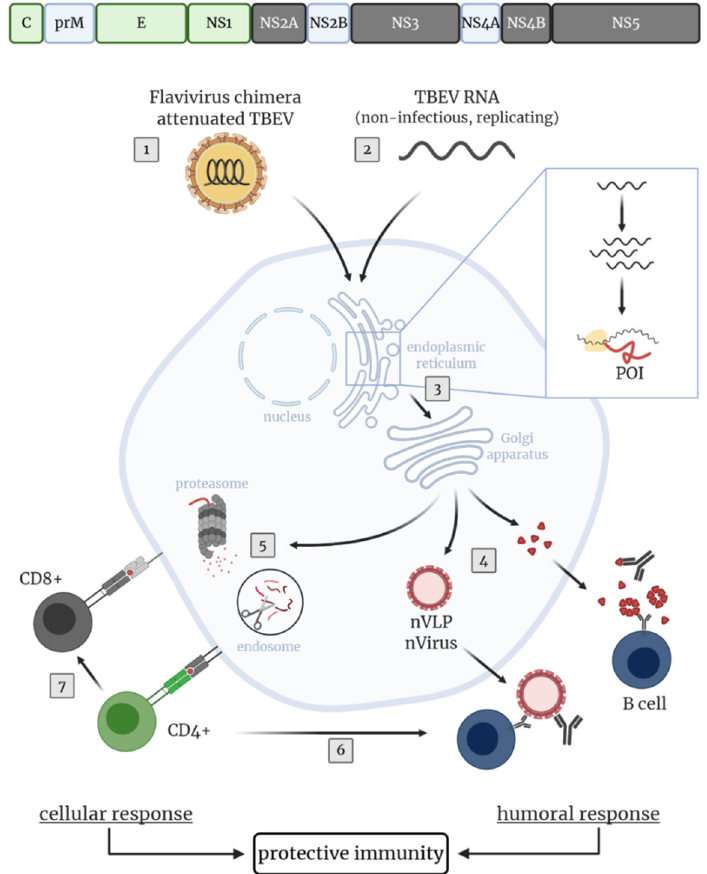
Figure 3. Inclusion of flavivirus non-structural proteins to enhance vaccine-induced immunity. The TBEV polyprotein with proteins inducing CD4 + (C, E, NS1) and CD8 + (NS2A, NS3, NS4B, NS5) T cell responses is shown. Upon immunization with live attenuated flaviviruses (1) or non-infectious, replicating TBEV RNA (2), structural as well as non-structural proteins are included, promoting a humoral but also an e ffi cient cellular immunity. (3) Immunization leads to the synthesis of proteins of interest (POIs), which are processed on di ff erent pathways leading to humoral and / or cellular immune responses. (4) Humoral immune response: POIs are either secreted into the extracellular space (NS1) or assemble into novel VLPs (nVLPs) or virions (nVirus) which are subsequently released from the cell. Thus, TBEV-specific B cells and antibodies are induced. (5) Cellular immune response: The POIs are degraded into peptides either by host proteases in endosomes or by proteasomes in the cytoplasm. By this process antigens are presented via MHC class II or I molecules to CD4 + or CD8 + T cells. CD4 + T cells promote the activation and proliferation of TBEV-specific B cells (6) and CD8 + T cells (7) with the development of memory responses. Created with BioRender.com.